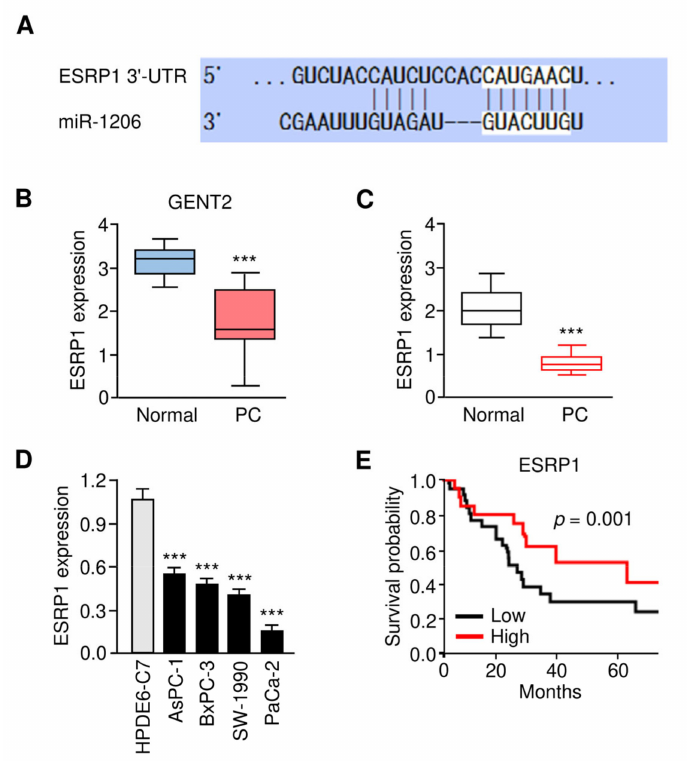
Figure 6. The Expression Pattern and Prognostic Significance of ESRP1 in PC. ( A ) The complementary sequence between miR-1206 and ESRP1 mRNA (TargetScan database). ( B ) ESRP1 expression in PC tissues and adjacent normal samples (GENT2 database). ( C ) ESRP1 mRNA expression in PC tissues and normal samples was examined using the qRT-PCR assay. ( D ) qRT-PCR analysis of ESRP1 mRNA expression in PC cells and normal cells. ( E ) Kaplan–Meier survival analysis of PC patients with lower or higher ESRP1 expression. The experiments in ( D ) were repeated three times independently with similar results. *** p